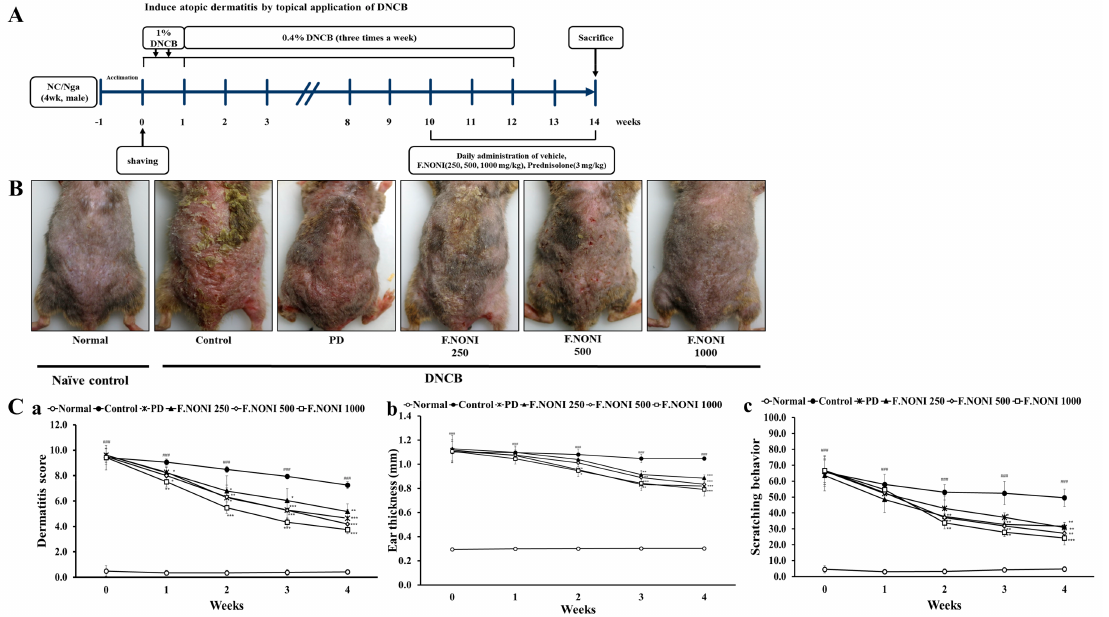
Figure 2. Experimental procedure and e ff ect of F.NONI on the clinical features of AD-like symptoms induced by DNCB in NC / Nga mice. ( A ) Schematic diagram of the experimental procedure for the induction of AD lesions and F.NONI treatment. ( B ) Photographic images of skin lesions in NC / Nga mice were taken on the last day of the experiment in the fourth week. ( C ) Clinical features in NC / Nga mice—( a ) dermatitis score, ( b ) ear thickness, and ( c ) scratching behavior—were evaluated three times a week in the term of the administration of vehicle, prednisolone, and F.NONI. The results were presented as mean ± SEM ( n = 6). ### p < 0.001 vs. normal, * p < 0.05, ** p < 0.01, *** p < 0.001 vs. control. Normal, untreated group; Control, atopic dermatitis induced by DNCB; PD, positive control (prednisolone 3 mg / kg) treated group; F.NONI (fermented Morinda citrifolia 250, 500, or 1000 mg / kg) treated group; DNCB